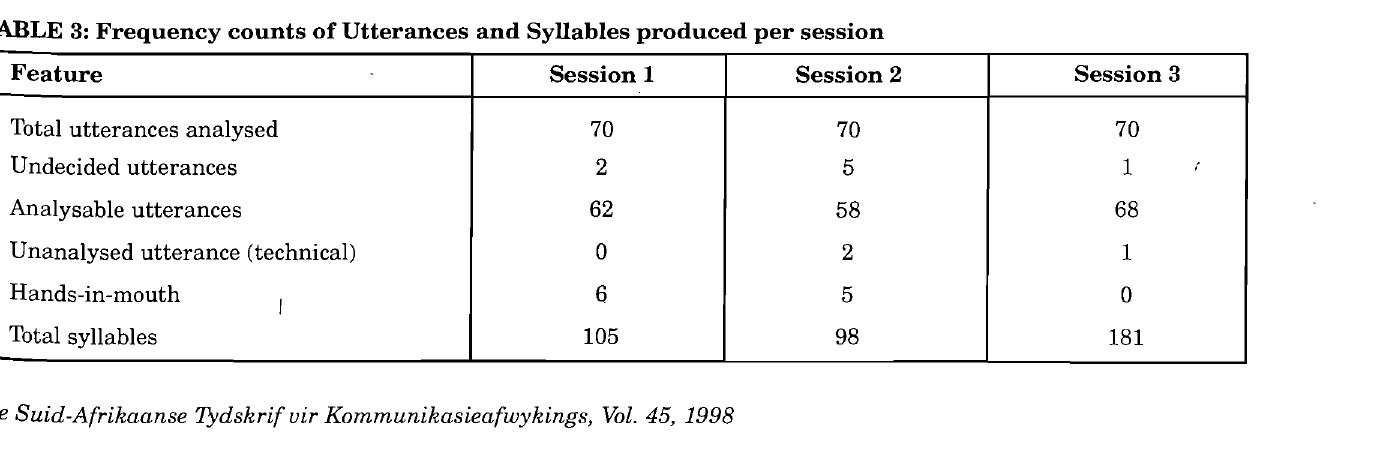
TABLE 3: Frequency counts of Utterances and Syllables produced per session